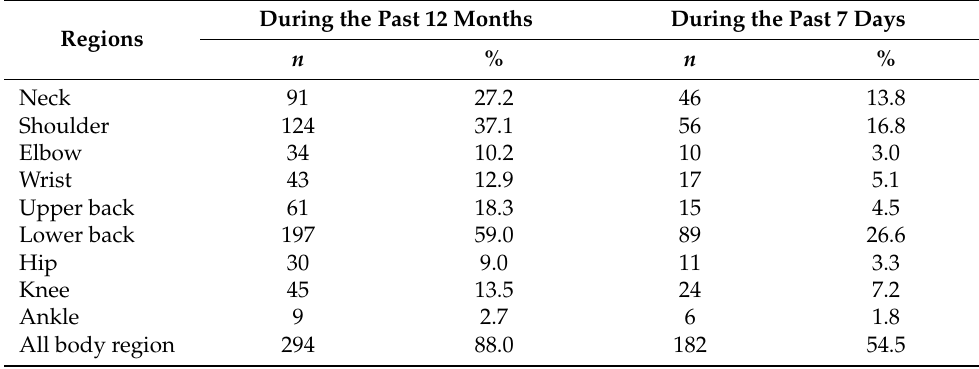
Table 3. Prevalence of MSDs during the past 12 months and 7 days ( n = 334).